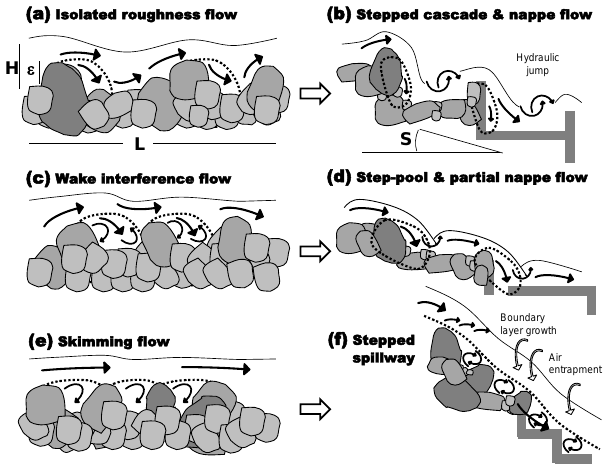
Figure 4. Analogies in flow characteristics, retardation processes, and energy dissipation structures for very different flow typologies: streams (a, c, e) and high-gradient natural or man-made stepped flows (b, d, f) . The combined values of flow depth ( H ), slope ( S ), and inundation ratio ( (cid:51) z = H/ε , where ε is the roughness size) ap- pear as strong geometrical controls over flow characteristics and ty- pologies. The very small inundation ratios ( (cid:51) z < 1) typical of over- land flows in hydrology (flows through emergent obstacles, includ- ing vegetation) correspond to ε values larger than H values (tortu- ous flows are best seen in the views from above of Fig. 8).